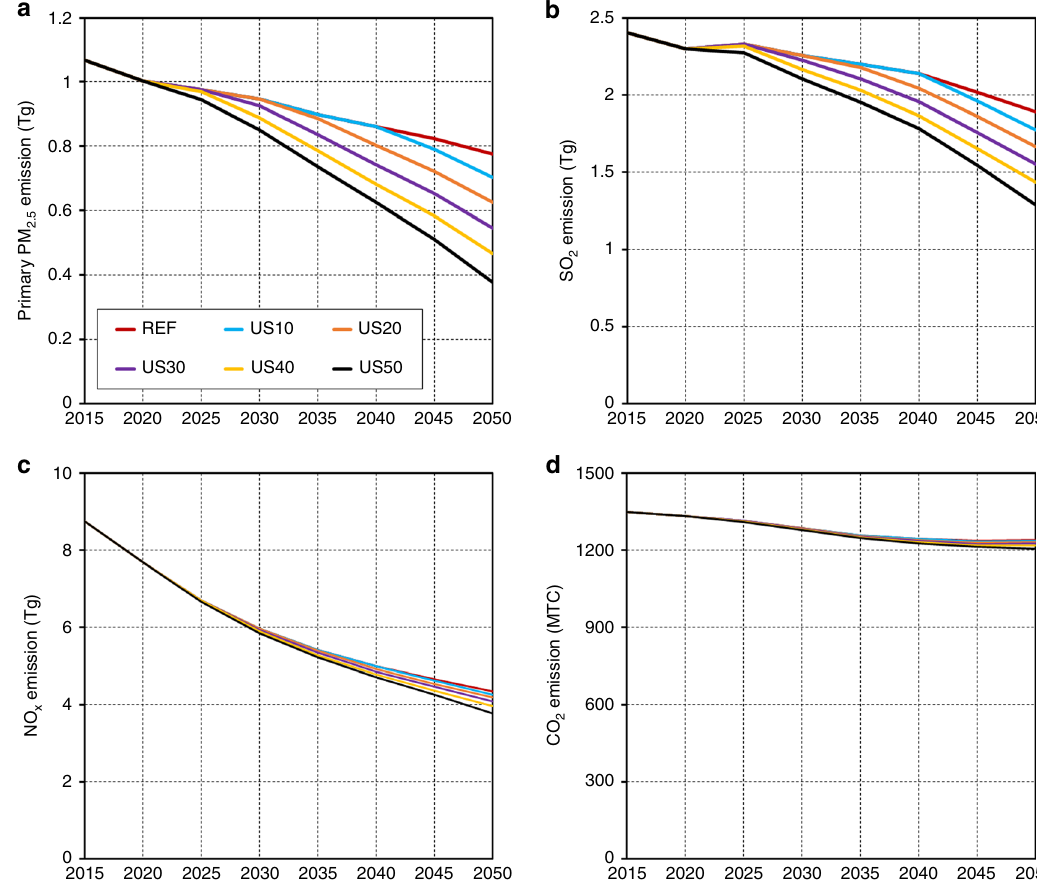
Fig. 2 Effects of PM 2.5 reduction stringency on national emissions. Compared with REF, more stringent PM 2.5 -related mortality costs (PMMC) reduction targets lead to greater reductions of the primary PM 2.5 ( a ) and SO 2 ( b ) emissions in 2050, respectively, but minor reductions of NO x ( c ) and CO 2 emissions ( d ). National emissions include anthropogenic sources from electricity, industry, transportation, and buildings sectors in continental US. Emissions from AK and HI are not included. Source data are provided as a Source Data fi